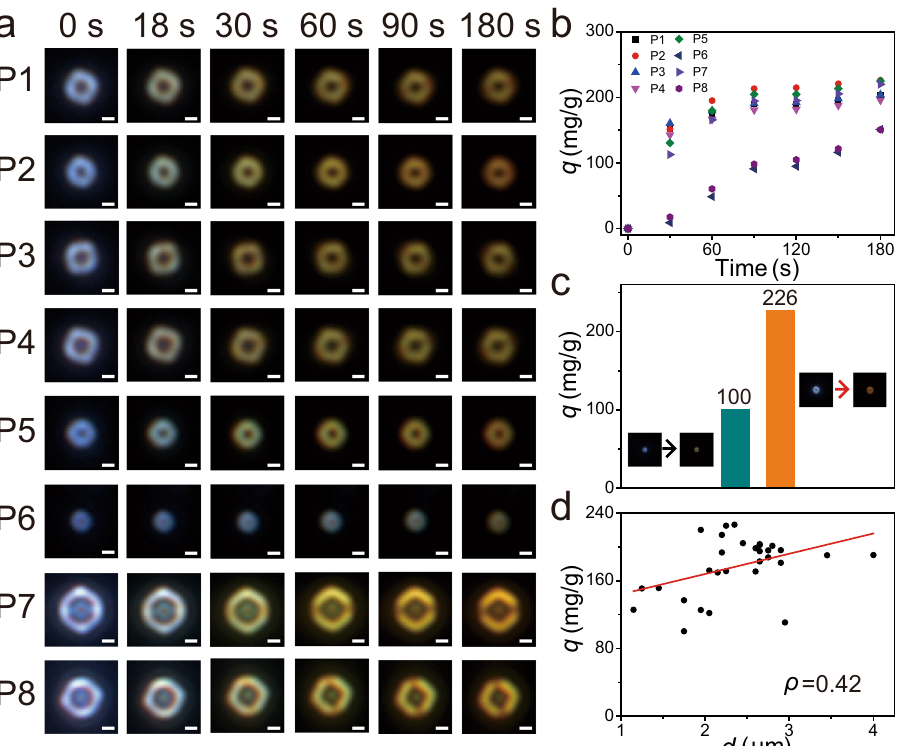
Fig. 4 Imaging the gaseous I 2 adsorption on ZIF-90 particles. a Time-resolved DFM images of gaseous I 2 adsorption on eight representative ZIF-90 particles (scale bar: 1 μ m) and ( b ) the corresponding adsorption kinetic. c Comparison of the absorption amount ( q ) between two ZIF-90 particles. The inset shows the DFM image of the ZIF-90 particles before and after adsorption of I 2 . d Correlation plot and the corresponding Pearson ’ s correlation coef fi cient ( ρ ) between absorption amount and diameter of ZIF-90